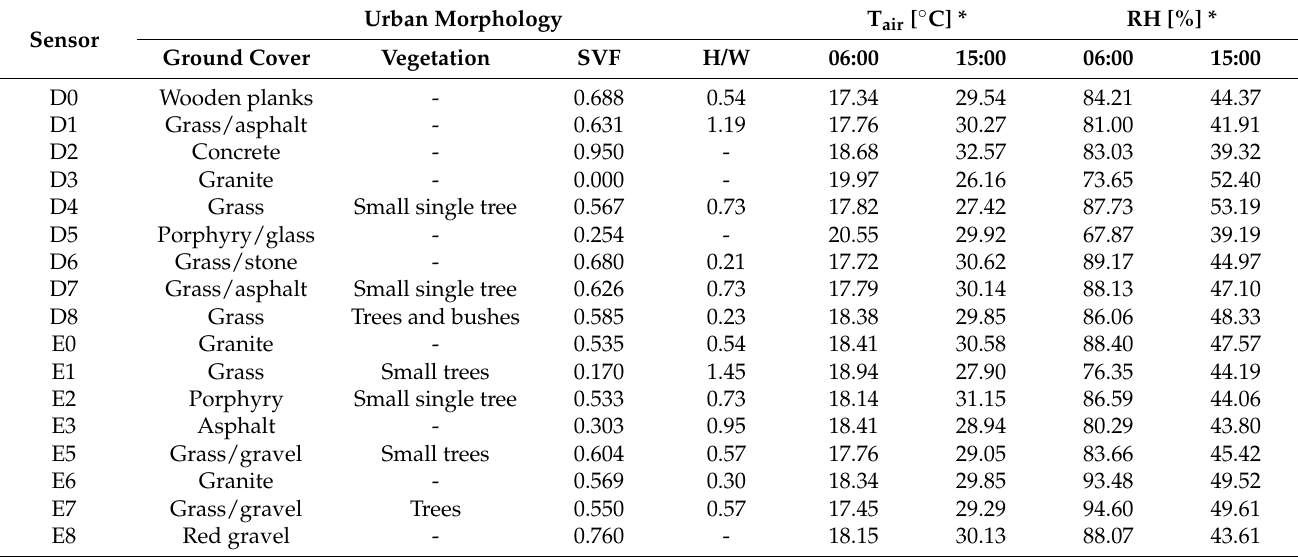
Table 1. Morphological characteristics and hourly averaged air temperature and relative humidity values measured by the sensor nodes in coldest (i.e., 06:00) and hottest (i.e., 15:00) conditions from